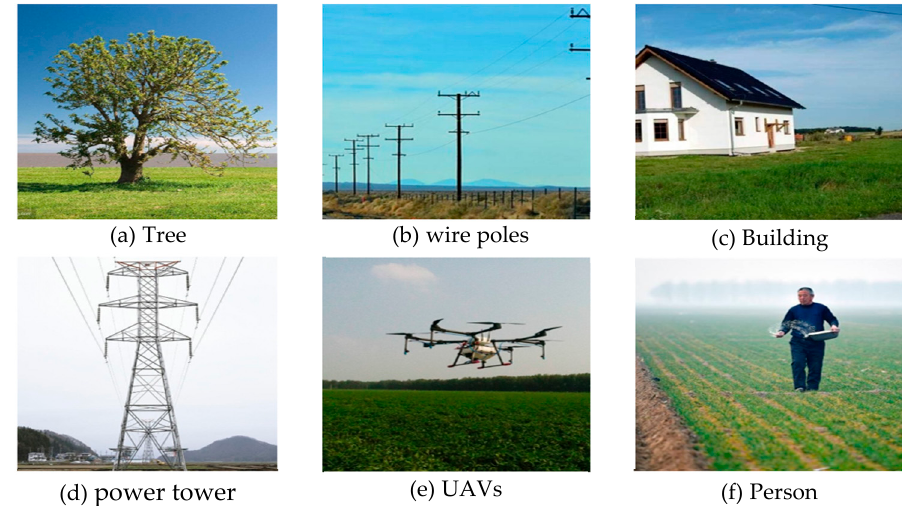
Figure 1. Examples of field obstacle images.